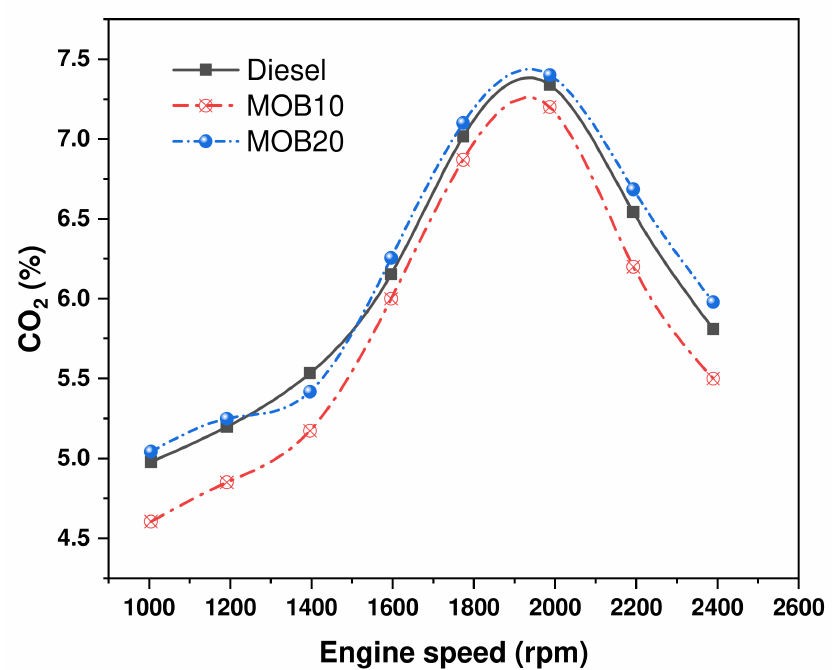
Figure 6. Carbon dioxide emissions of Moringa oleifera biodiesel blends and diesel at various en- gine